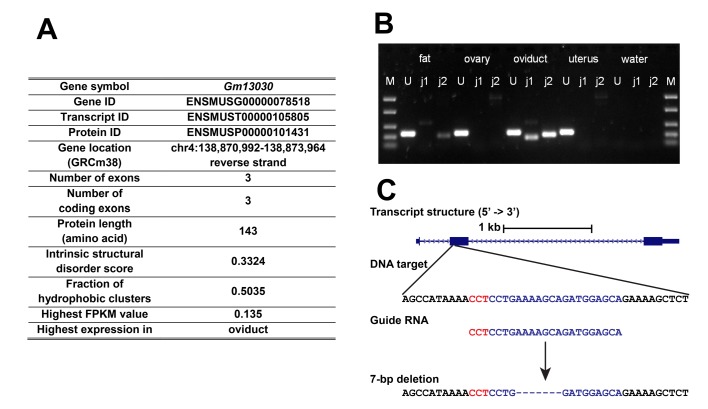
General information of Gm13030, expression, and knockout strategy.(A) General information on transcript ID, location and protein characteristics. (B) Reverse transcription PCR across intron junctions to study Gm13030 expression in gonadal fat pad, ovary, oviduct, and uterus. Fat: gonadal fat pad; M: marker (from top to bottom: 1500 bp, 850 bp, 400 bp, 200 bp, 50 bp); U: Uba1 (control gene, 255 bp); j1: Gm13030 junction 1 (161 bp); j2: Gm13030 junction 2 (209 bp). (C) Transcript structure, DNA target, guide RNA, and depiction of the deletion created by the CRISPR/Cas9 knockout of Gm13030. The 20-nt guide sequence is colored blue and the 3-nt PAM is colored red. The induced deletion was verified by sequencing.